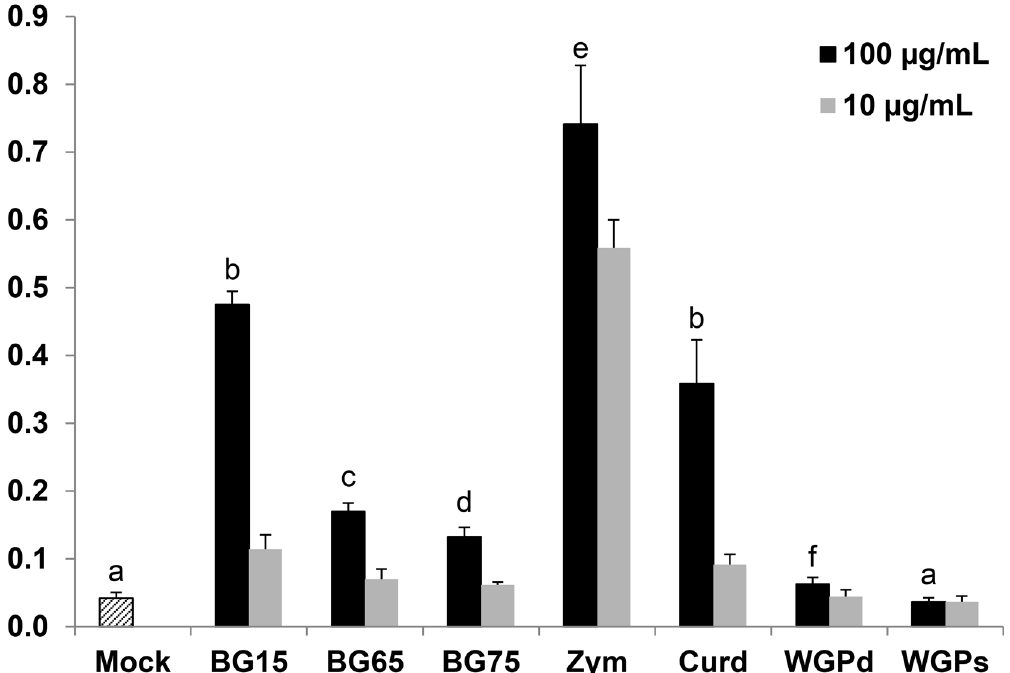
Fig 1. Saccharomyces cerevisiae (Sc) extracts enriched in β -glucan (BG) are much weaker inducers of NF κ B/AP-1 activity in RAW-Blue ™ macrophages than other sources of BG. NF κ B/AP-1 activity was determined by a colorimetric enzyme assay using RAW-Blue ™ macrophages as reporter cell line. Cells were treated for 16 h with 100 or 10 μ g/mL of various Sc BG extracts (BG15, BG65 and BG75) or with zymosan, curdlan, dispersible WGPd and soluble WGPs as controls. Data are expressed as the mean OD 650nm ± SD of three independent experiments performed in triplicate. Mean values not sharing the same letter are significantly different according to the Student ’ s t-test ( p < 0.05). Comparisons are shown for BG compounds used at 100 μ g/mL.